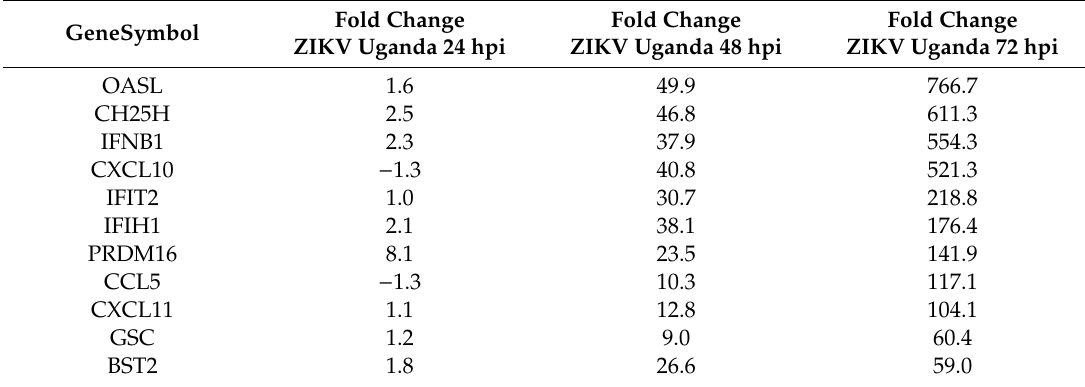
Table 2. Top upregulated genes by ZIKV